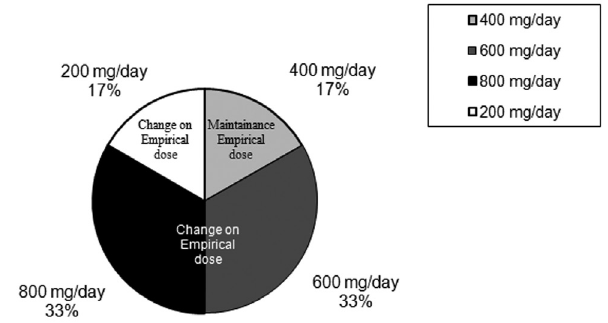
Figure 3 - Dose adjustment of fluconazole to reach clinical efficacy was required in 5/6 burn patients with fungal infection. Antifungal therapy was started at the empirical dose regimen (200 mg twice daily, fast infusion). Data are expressed as the percentage of patients that required changes to the empirical dose regimen to reach clinical